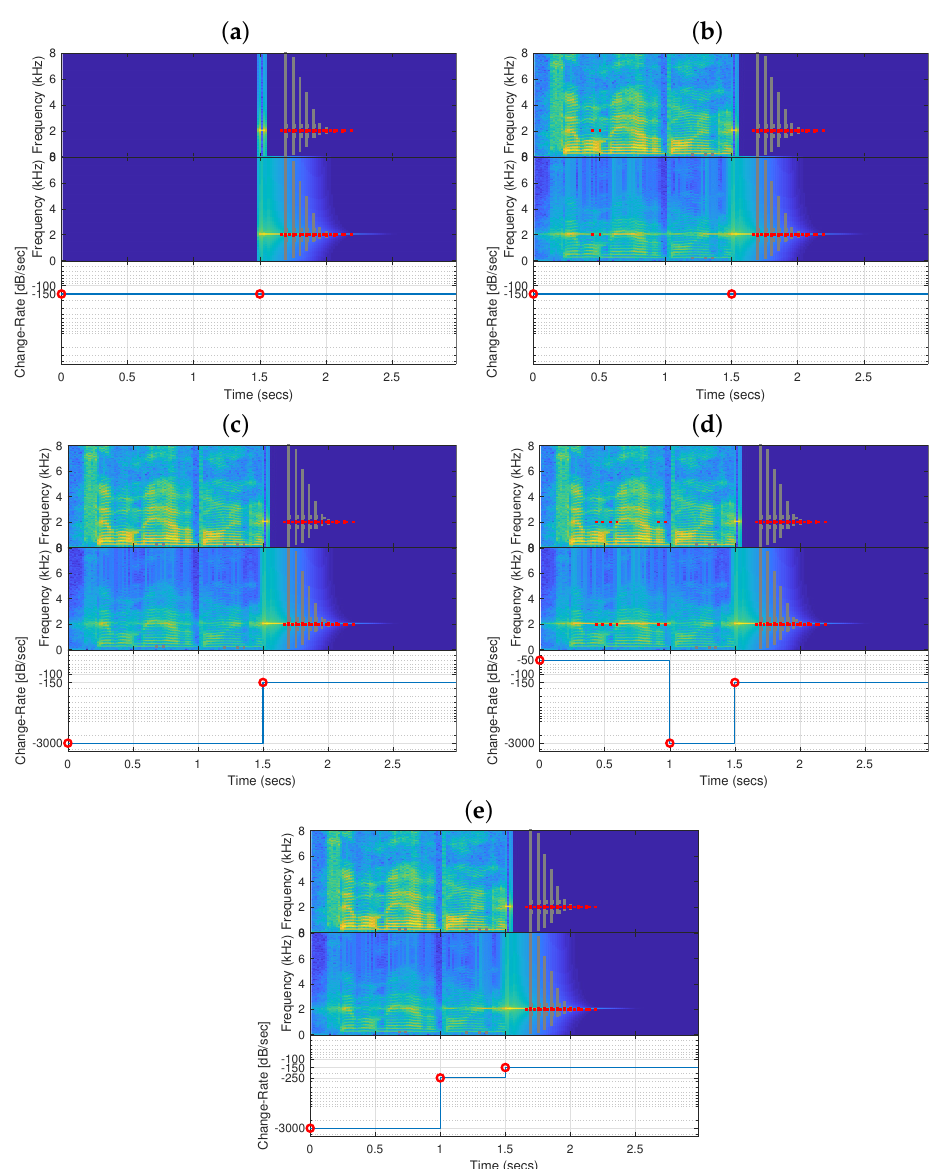
Figure 5. Summary of howling scenarios for a Close Stable Pole feedback scenario: ( a ) Impulse Response Howl; ( b ) Speech Howl; ( c ) Full Stability Gain-Control Howl; ( d ) Recovery Gain-Control Howl; ( e ) Increasing Gain-Control Howl. The howling scenarios vary by the input signal and the configured signal-magnitude change rate over time. The examined two-pole TF has a pole at frequency 2000 Hz, with a magnitude that corresponds to a signal-magnitude change rate of − 150 dB/s. Each figure includes a spectrogram comparison between u ( n ) and y ( n ) , and the applied pole magnitudes over time. The howling artifacts in y ( n ) were retrospectively detected using the Plain MSD-based howling detector, and are marked in both spectrograms by red